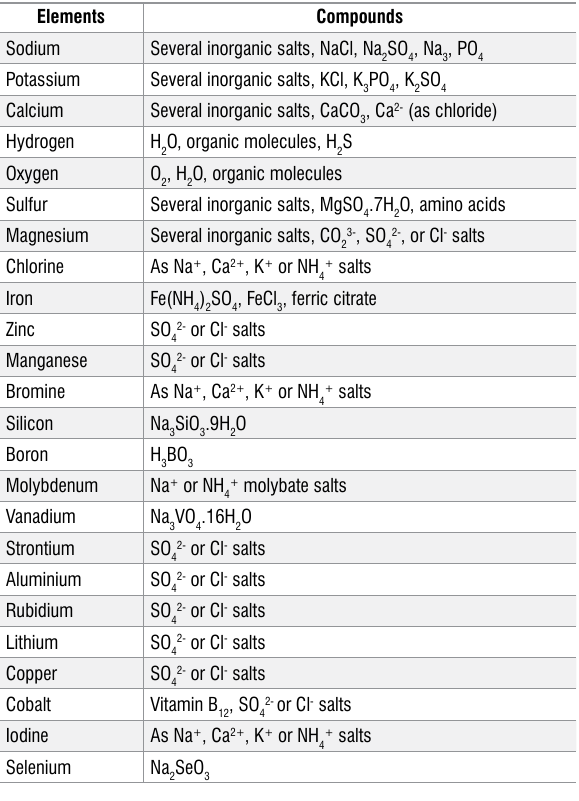
Under nitrogen-rich conditions, rapid cell division and chlorophyll accumulation occur. Under depleted nitrogen conditions, no cell division occurs, but there is high lipid biomass accumulation for several SO , Na , PO 2 4 3 4 PO , K SO 3 4 2 4 , Ca 2- (as chloride) 3